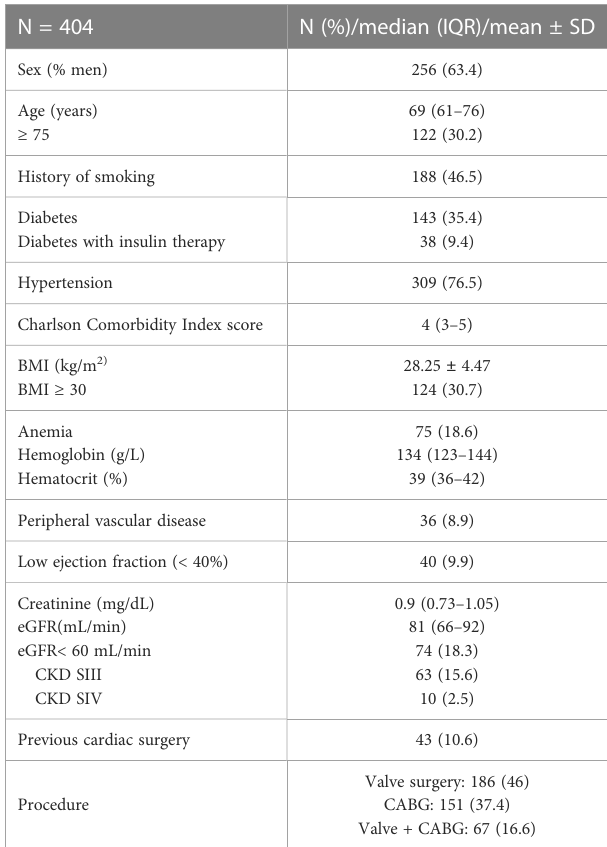
TABLE 1 Baseline